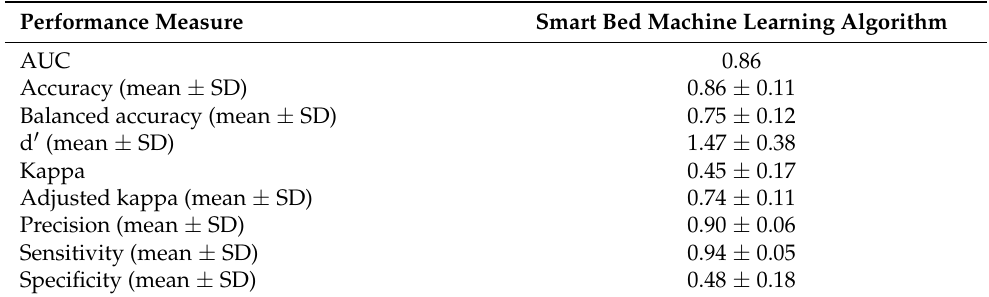
Table 2. Performance of the smart bed’s machine learning algorithm for sleep/wake detection.